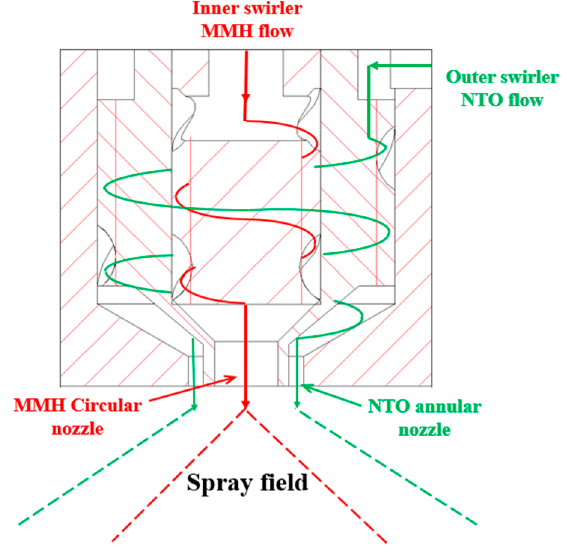
Figure 5. The typical structure of the NTO flow channel with an annular nozzle and MMH flow channel with a circular nozzle.